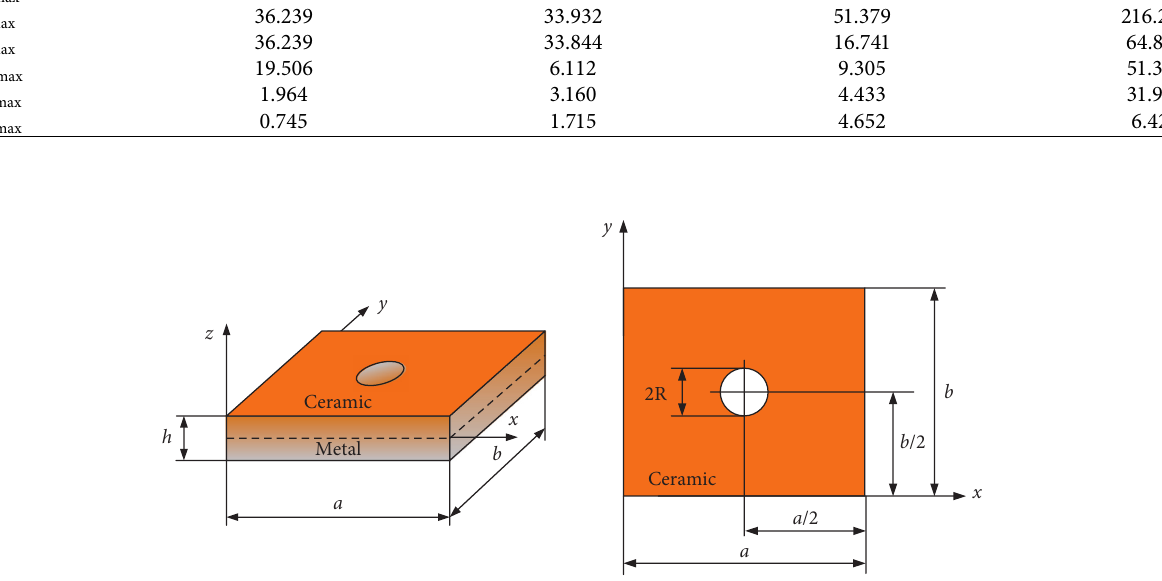
Table 5: The maximum values of deflection and stress of FGM nanoplate subjected to sinusoidally distributed load q and ψ � 1.